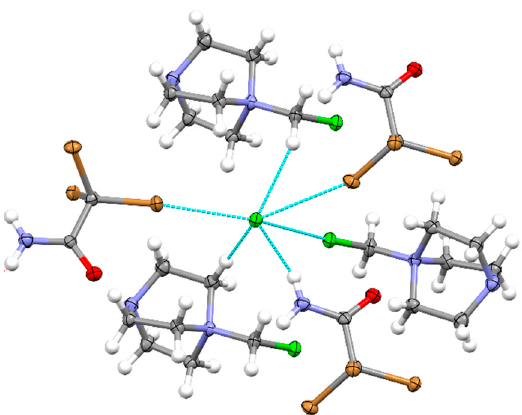
Figure 6. Intermolecular interactions by chloride anions with tribromoacetamide and DABCO-CH 2 Cl + in (DABCO-CH 2 Cl)Cl · CBr 3 CONH 2 co-crystals 6. (Note: blue line show contacts shorter than the sum of van der Waals separations, counter-ions are omitted for clarity.).